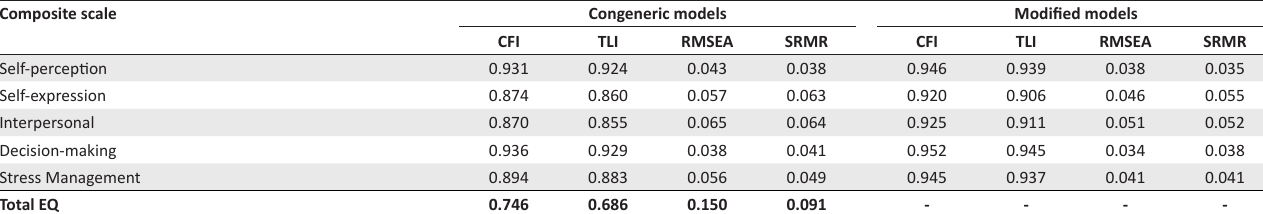
TABLE 4: Fit statistics for the composite scales of the Emotional Quotient Inventory 2.0. Composite